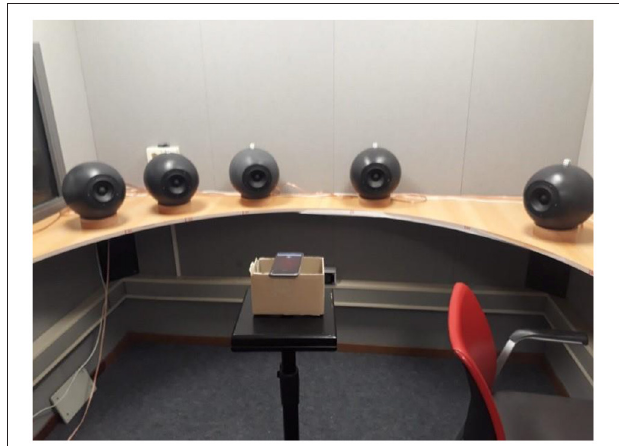
FIGURE 1 | Set-up of the smartphone in front of the